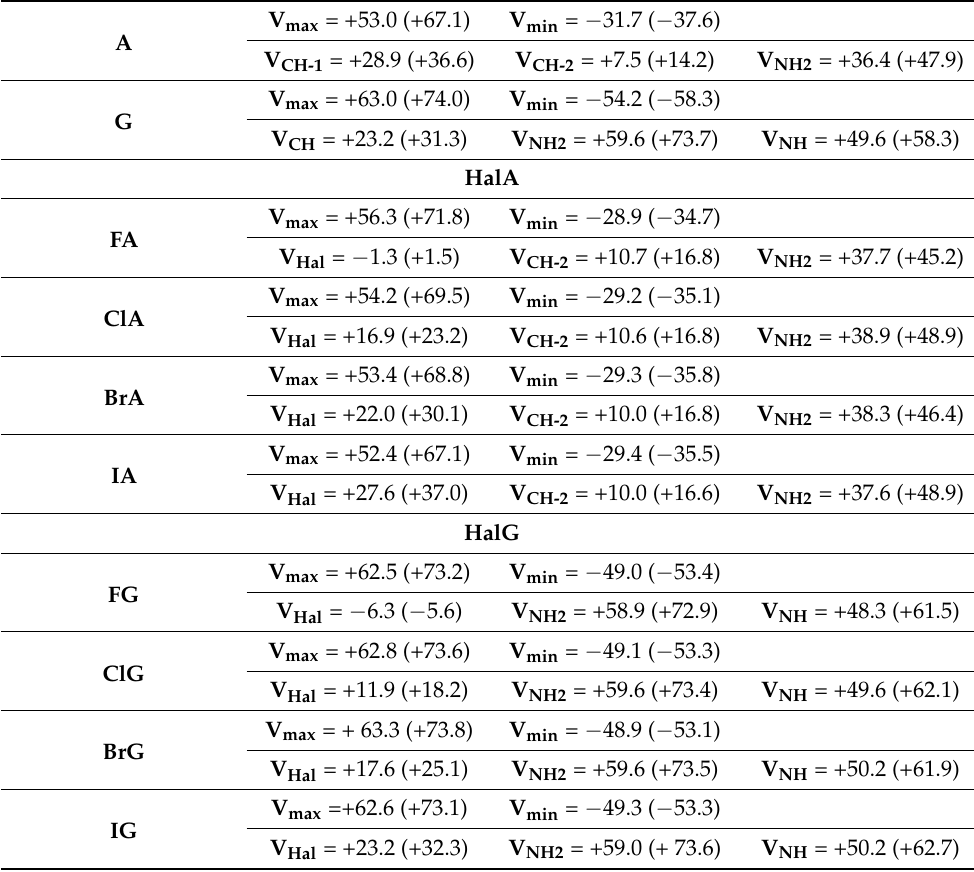
Table 2. Molecular electrostatic potential values of the halogen bond and hydrogen bond donor groups (V Hal , V CH-1 , V CH-2 , V NH and V NH2 , in kcal/mol). These were calculated over the Halogen and H atoms belonging to the C–Hal, C–H and N–H bonds (see the white asterisks in Figure 3 to locate the specific position where the MEP was computed) involving non-halogenated and halogenated Adenine and Guanine nucleobases at 0.001 a.u. Values in parenthesis correspond to an isovalue contour of 0.002 a.u. (also in kcal/mol). The MEP maxima (V max ) and minima (V min ) values for each nucleobase are also indicated in